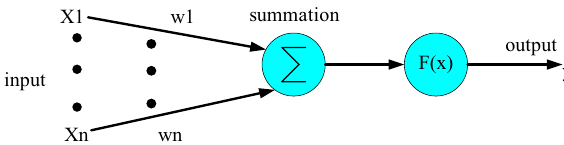
Figure 1: Mathematical model of a